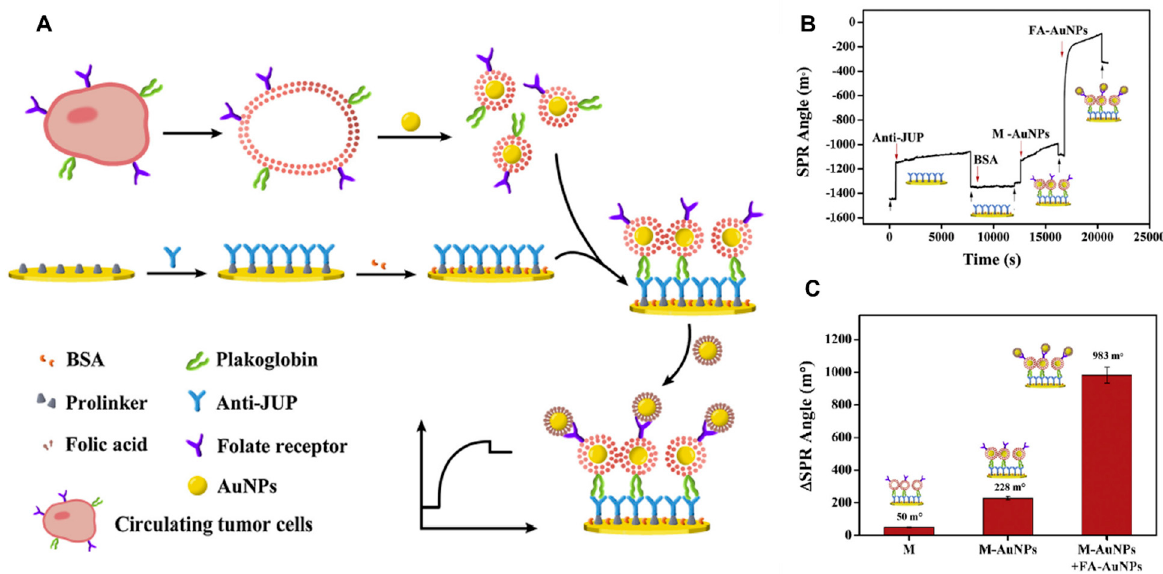
Figure 5. ( A ) A diagrammatic illustration of circulating tumor cells on the surface of the chip. ( B ) Sensorgram of the SPR, deionized water rinse procedure is represented by the black arrows, whilst the other modification procedures are represented by the red arrows. ( C ) Representation of SPR angle alteration when cancerous cell membrane alone, M-AuNPs, and FA-AuNPs–M-AuNPs are introduced to the anti-JUP engineered gold chip surface [116].